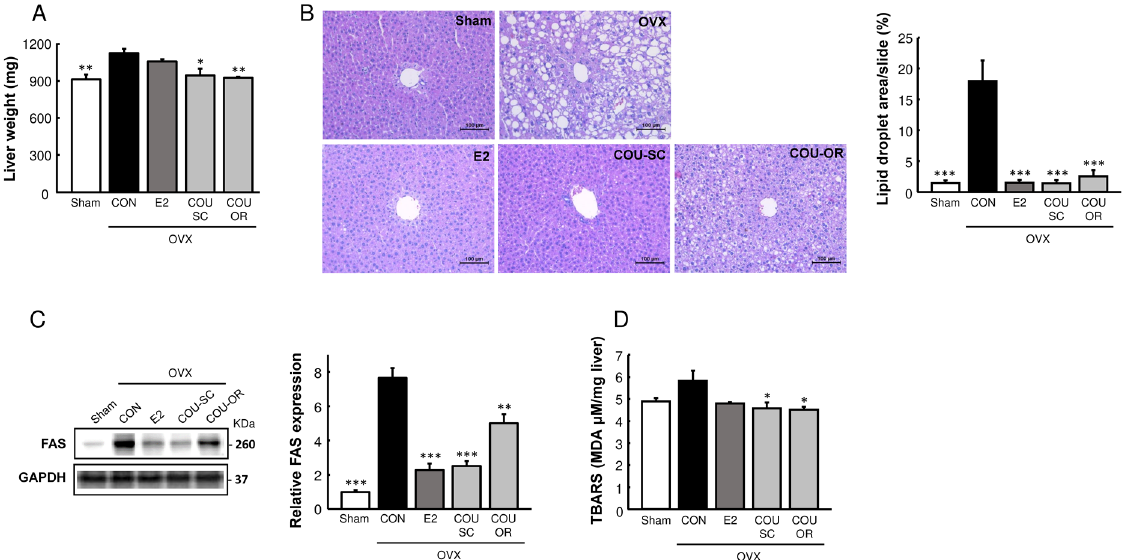
Figure 3. Preventive effects of coumestrol on hepatic steatosis in OVX mice fed a HFD. ( A ) Liver weight, ( B ) representative H&E-stained sections of liver (scale bar = 100 μ m) with quantitative data, and ( C ) Western blot of hepatic fatty acid synthase (FAS) with quantitative data. ( D ) Concentrations of thiobarbituric acid reactive substances (TBARS) in liver were expressed as malondialdehyde (MDA) equivalents. Values represent means ± SEM ( n = 7 for ( A ) and ( D ), n = 4 for ( B , C )). CON, control; E2, 17 β -estradiol; COU-SC, coumestrol subcutaneous treatment; COU-OR, coumestrol oral treatment; OVX, ovariectomized; GAPDH, glyceraldehyde-3-phosphate dehydrogenase; KDa, kilodaltons. * Significantly different from the OVX control group (* p < 0.05, ** p < 0.01, *** p < 0.001).